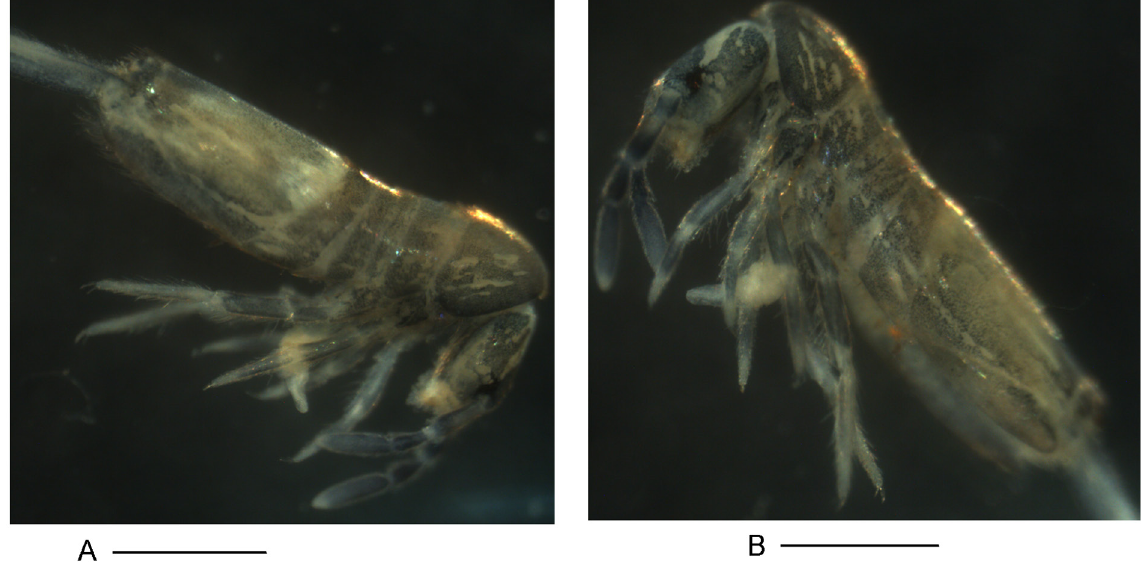
Fig. 1. Lepidocyrtus ( A. ) huizhouensis sp. nov. A–B . Habitus. Scale bars: 500